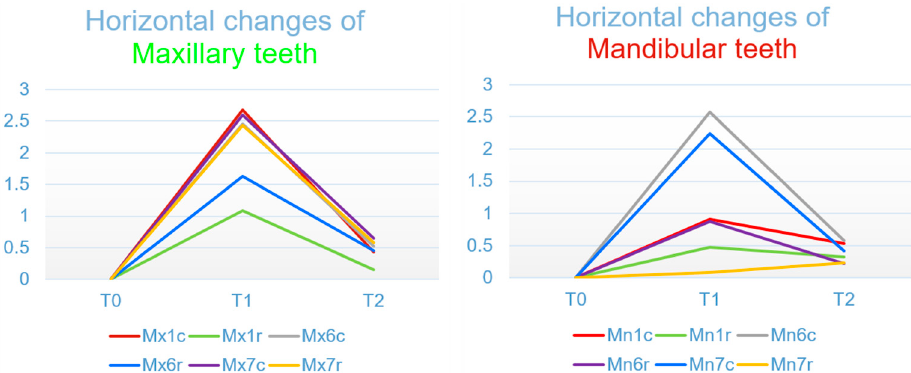
Figure 8. Horizontal changes of maxillary and mandibular teeth.